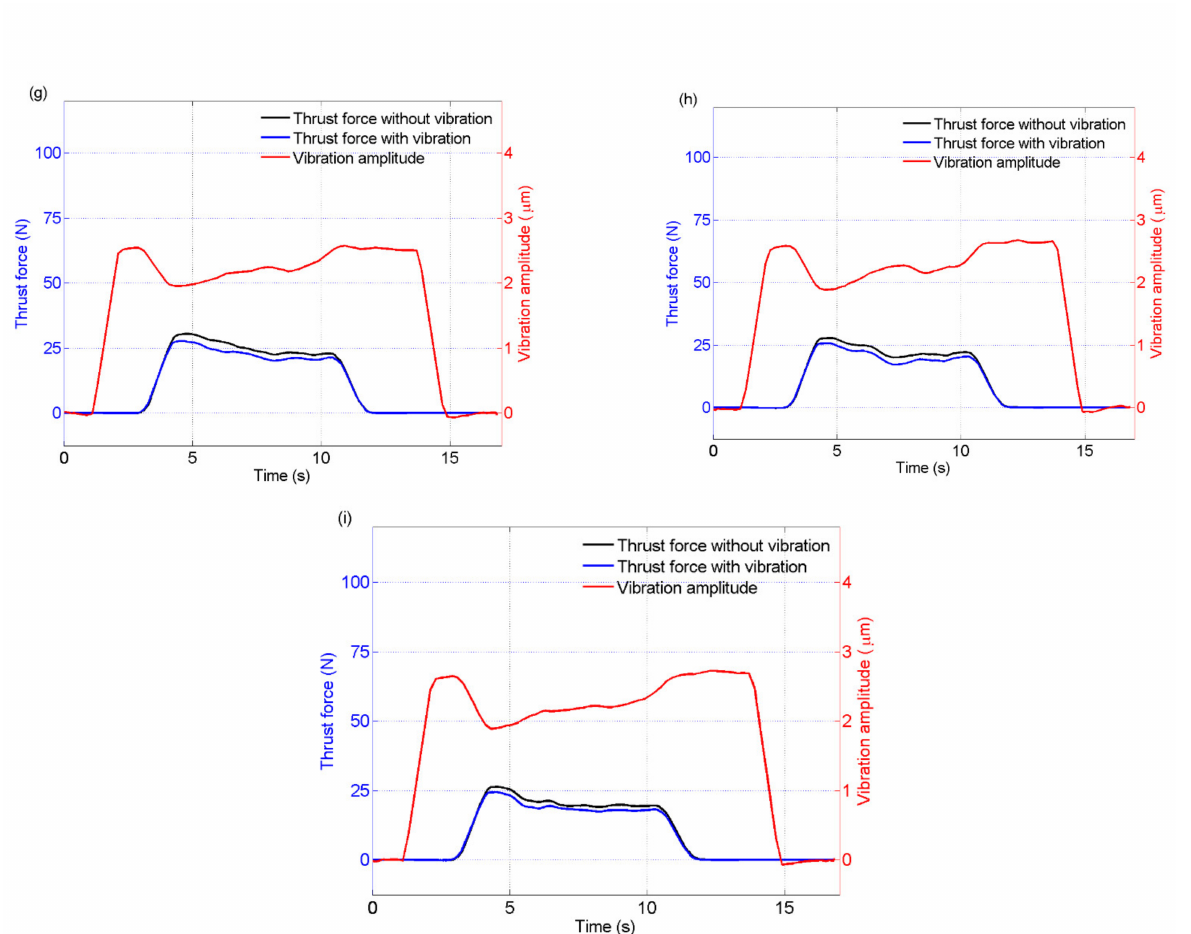
Figure 7. Variations of thrust force and vibration amplitude during hole-drilling process with different spindle speeds: ( a ) 500 rpm; ( b ) 1000 rpm; ( c ) 1500 rpm; ( d ) 2000 rpm; ( e ) 3500 rpm; ( f ) 5000 rpm; ( g ) 6500 rpm; ( h ) 8000 rpm; ( i ) 9500